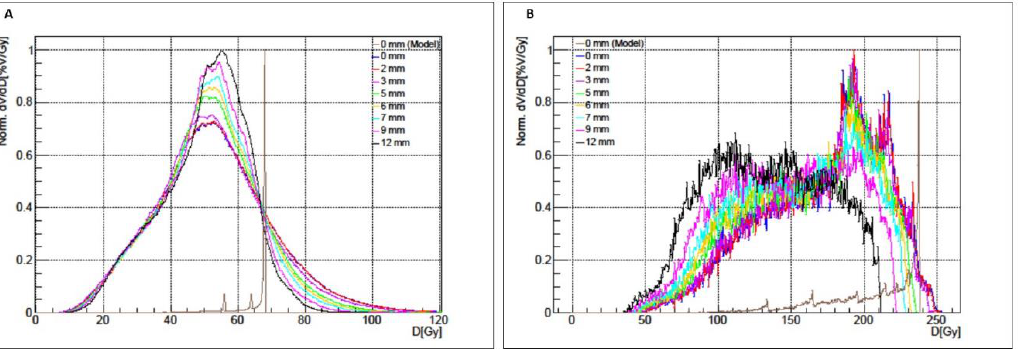
Figure 5. Integral Dose–Volume Histograms (iDVHs) for whole liver compartment ( A ) and for the 37 mm sphere ( B ), obtained with different Gaussian filters. Mean absorbed doses and respective standard deviations are also reported.